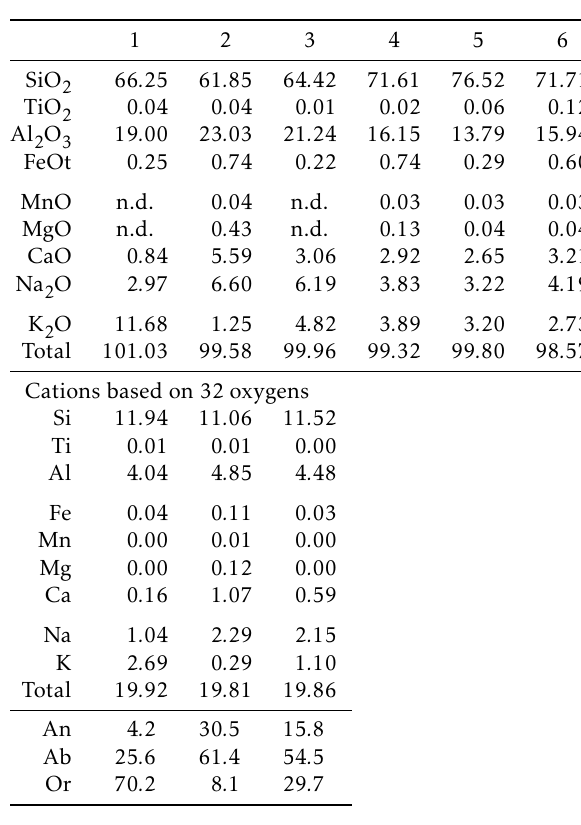
Table 7: Analyses in the large crystallised melt pools shielded in the garnet megacryst shown in Figure 10. n.d. = not detected (below detection limit). Com-